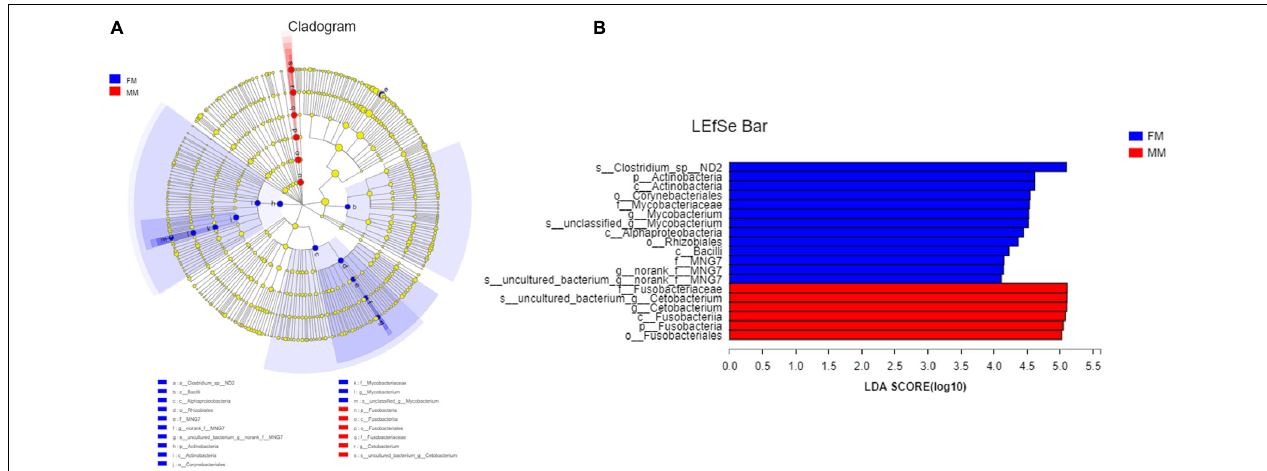
FIGURE 5 | LEfSe map of species differences between the FM group and MM group at the species level. (A) LEfSe cladogram, (B) highly significant bacteria with LDA score > 4.